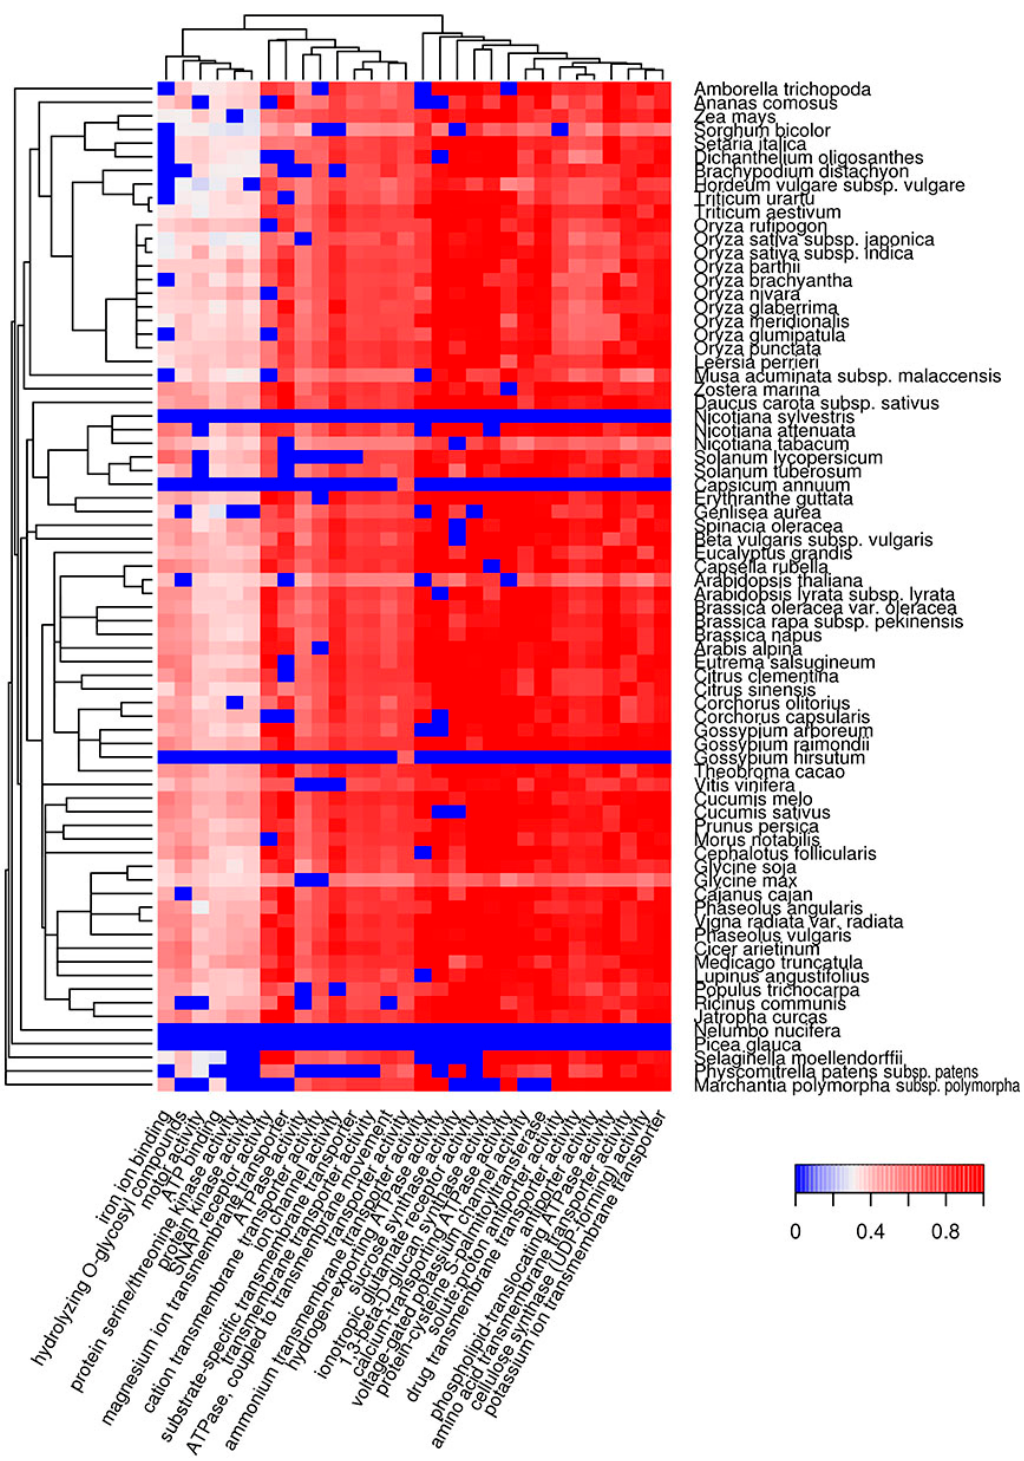
Figure 2. Heat map of GO molecular functions in which potentially amyloidogenic proteins predicted by Waltz are overrepresented. For such proteins, the top 30 GO terms from the molecular function ontology are shown. The color of the cells denotes the fraction of potentially amyloidogenic proteins predicted by Waltz among all proteins annotated with this term. All cells with p -values greater than 0.01 have values of 0 ( dark blue ). The dendrogram of plant species corresponds to their phylogenetic tree. GO, Gene Ontology.